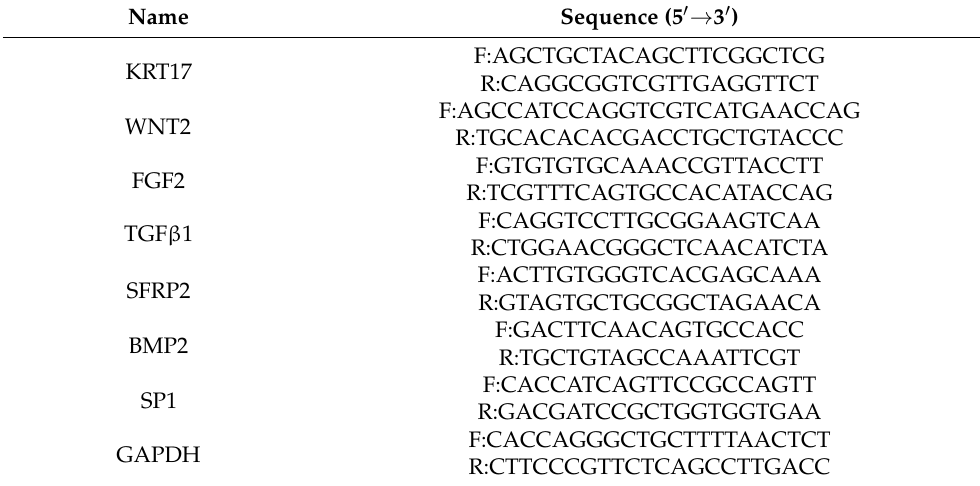
Table 10. Primers for qPCR.